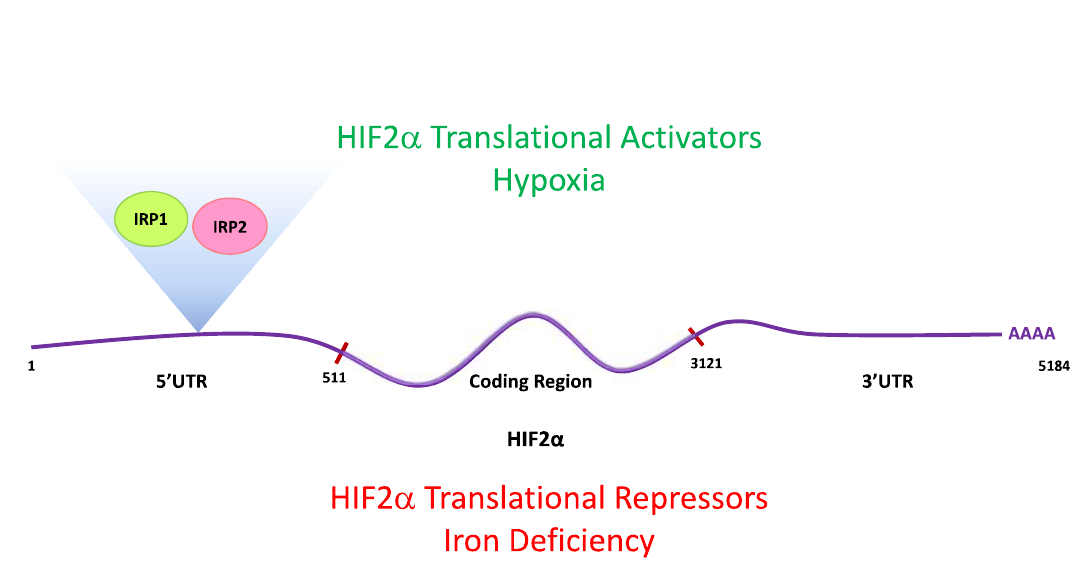
Figure 1. Schematic of the HIF α mRNAs and their RNA-binding proteins (RBPs). Schematic showing the known HIF1 α and HIF2 α RBPs, the region of the mRNA they are known to bind to and the known physiological modulators of HIF1 α and HIF2 α translation rates. The positions of the start of the 5’ UTR, coding region and the 3’ UTR are taken from the nucleotide sequences NM_001530 (HIF1A) and NM_001430.5